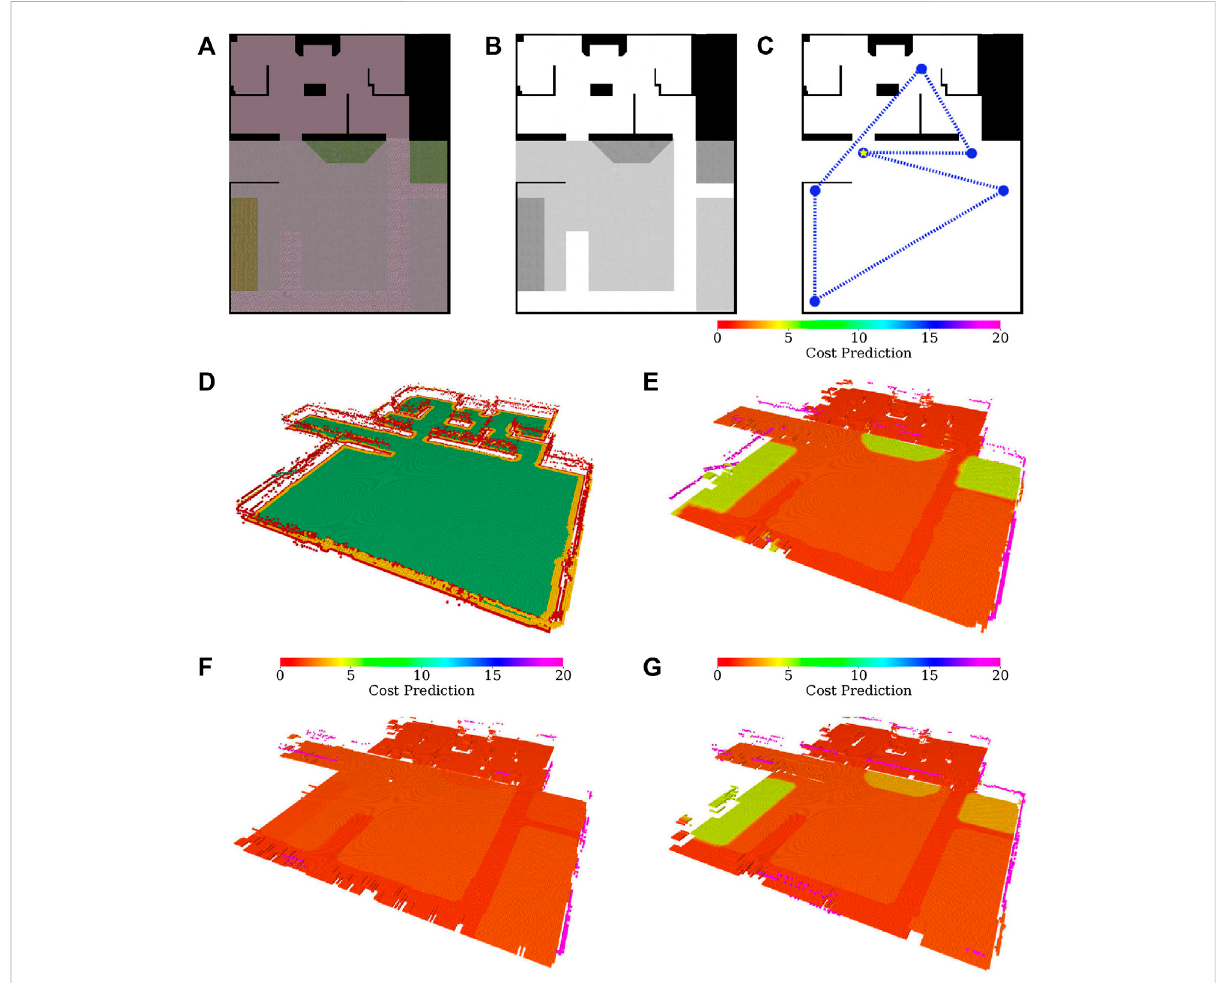
FIGURE 8 Large simulated environment (A) color and (B) relative traversability, (C) and the test tour through the environment, which starts at the starred node and is counter-clockwise. The built maps of the large simulated environment: (D) geometric map and (E) merged costs used for planning after exploration using the proposed approach; merged costs ofter exploration using the spatial-only model while (F) avoiding and (G) traversing rough terrain,